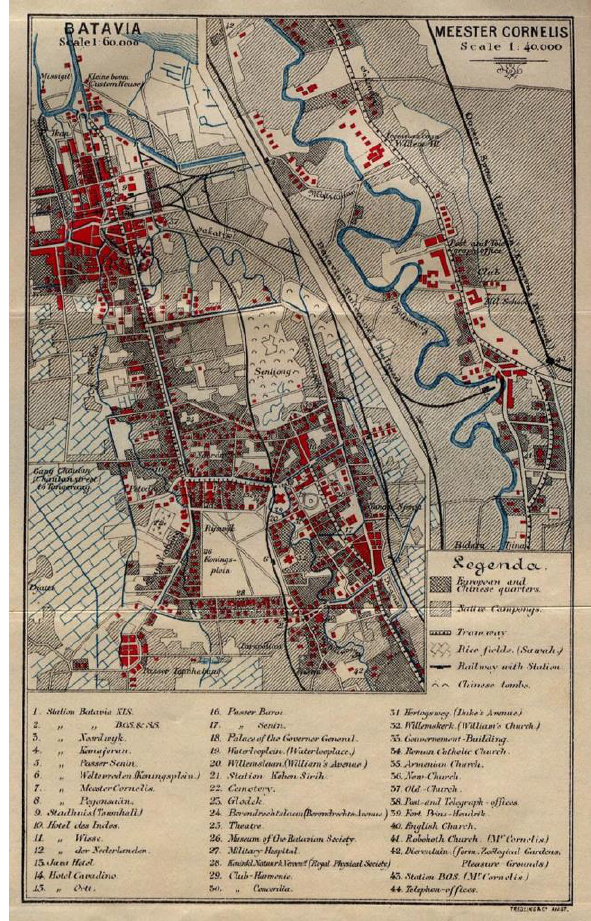
Figure 14. 1897 map of Batavia highlighting the city’s center shift and the interweaving connection that lies between the two centers: Batavia-stad and Weltevreden; Meester